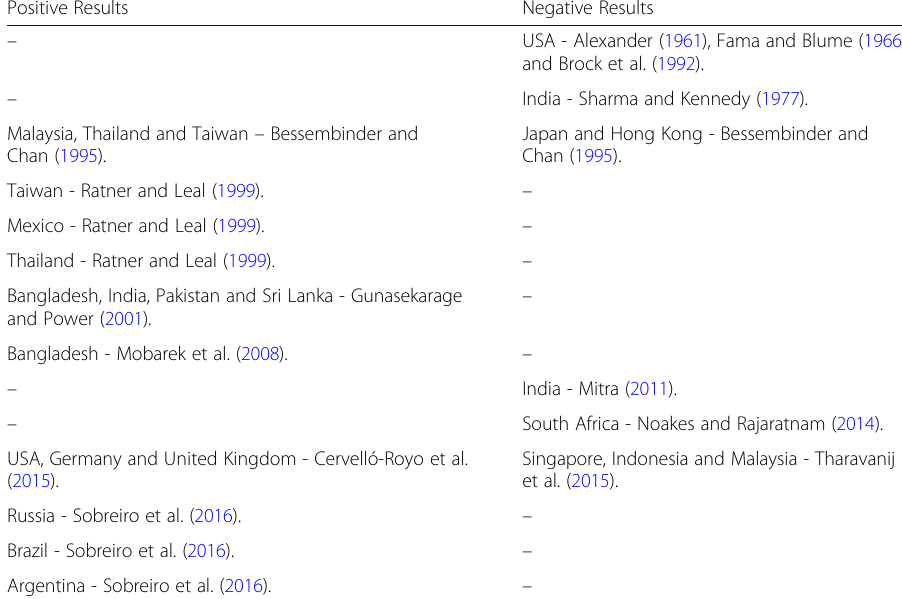
Table 1 Summary of the profitability of TA around the world according to researchers from